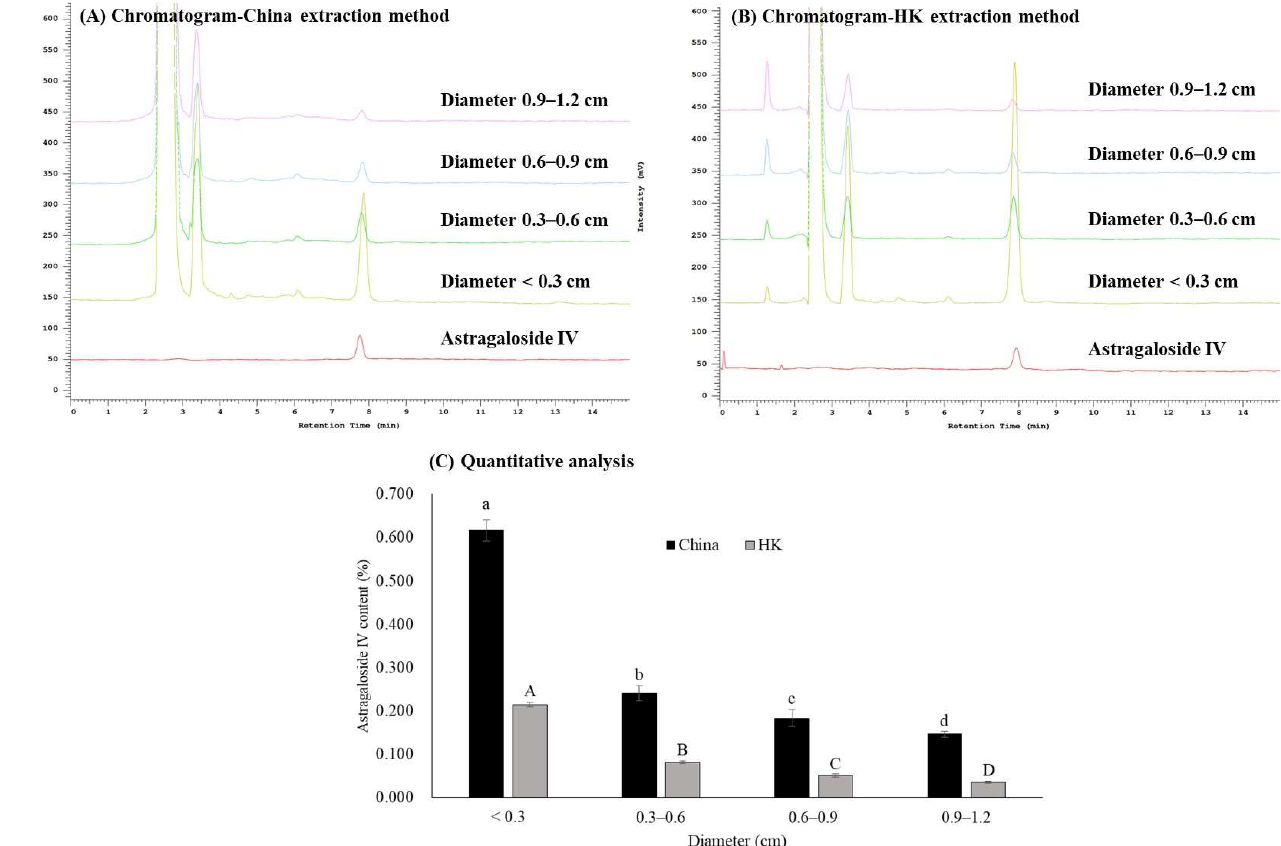
Figure 1. Effects of different diameters on the content of Astragaloside IV in Astragali radix (AR). HPLC chromatogram of standard solution (Astragaloside IV) and test solution (AR with different diameter sizes) based on the China ( A ) and HK ( B ) extraction method. ( C ) Quantitative analysis of Astragaloside IV content with different diameter sizes. Data are expressed as mean ± SD from three separate experiments; means not sharing an alphabetic letter (lowercase for China and uppercase for HK) differs statistically ( p < 0.05). Abbreviations (alphabetically): China, the Pharmacopoeia of